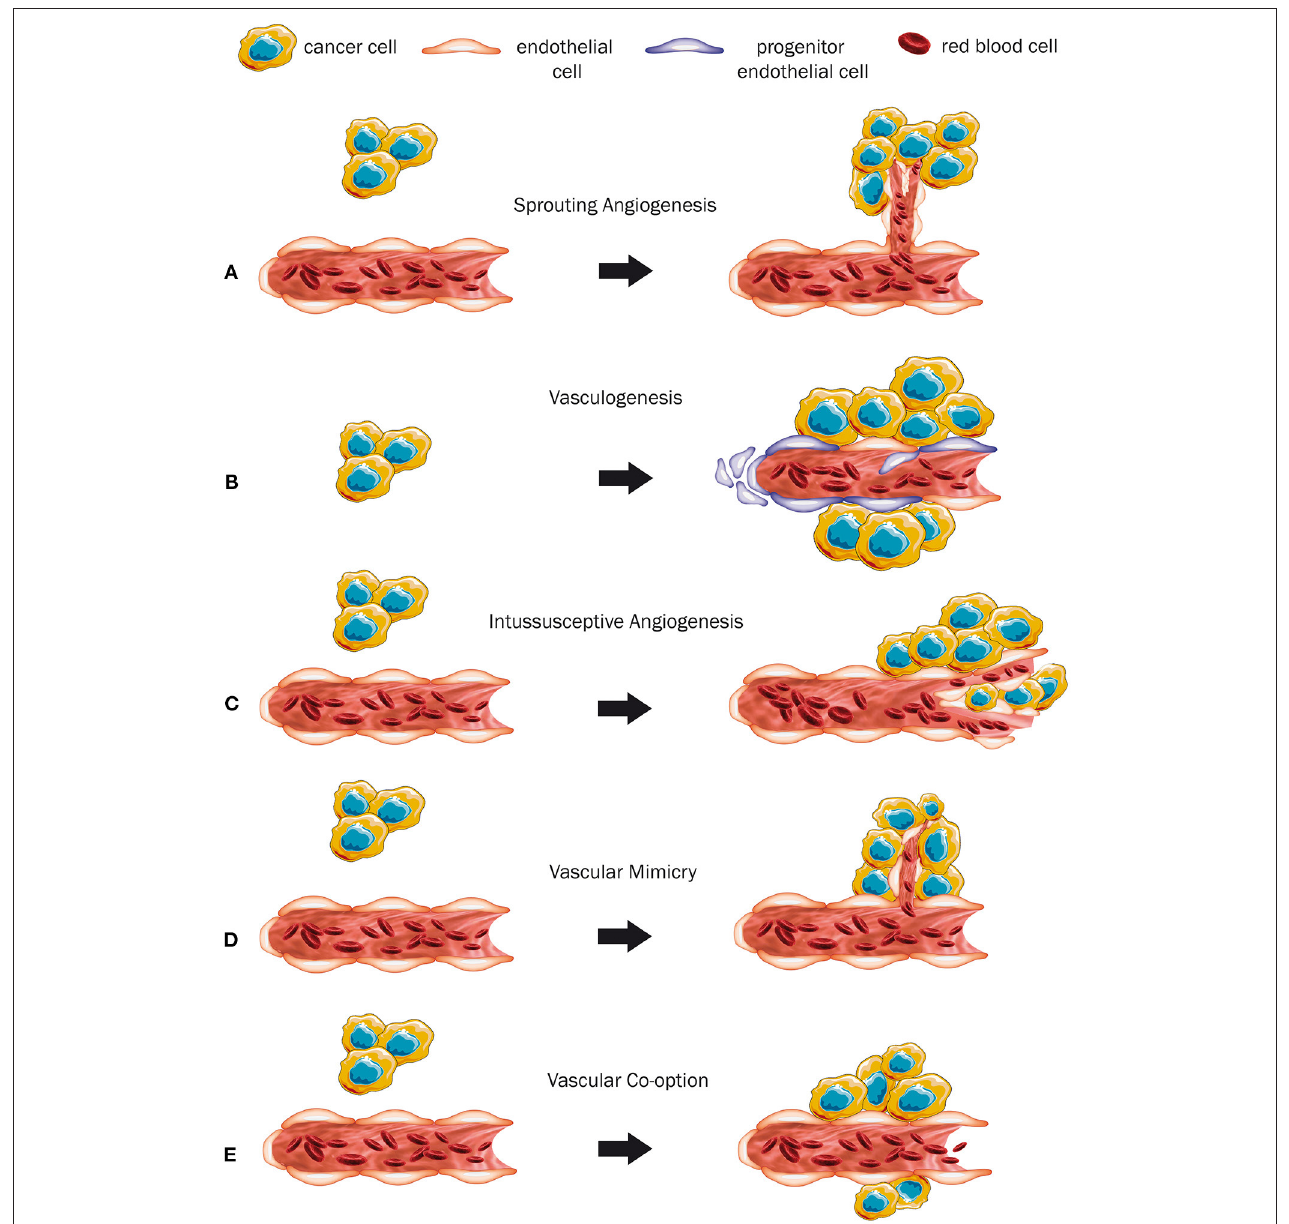
FIGURE 1 | Modes of vascularization (A–E) . (A) The mechanism of sprouting angiogenesis. As the tumor grows, sprouting of new immature vessels from a mature preexisting vessel is induced. (B) Vasculogenesis, a mechanism where a completely new vessel is formed by progenitor cells. (C) Intussusceptive angiogenesis. Hereby, a pre-existing vessel is promoted to split itself into two new ones. (D) Vascular mimicry. The tumor cells form a vessel-like structure themselves. (E) Co-option of a pre-existing mature blood vessel by expanding tumor